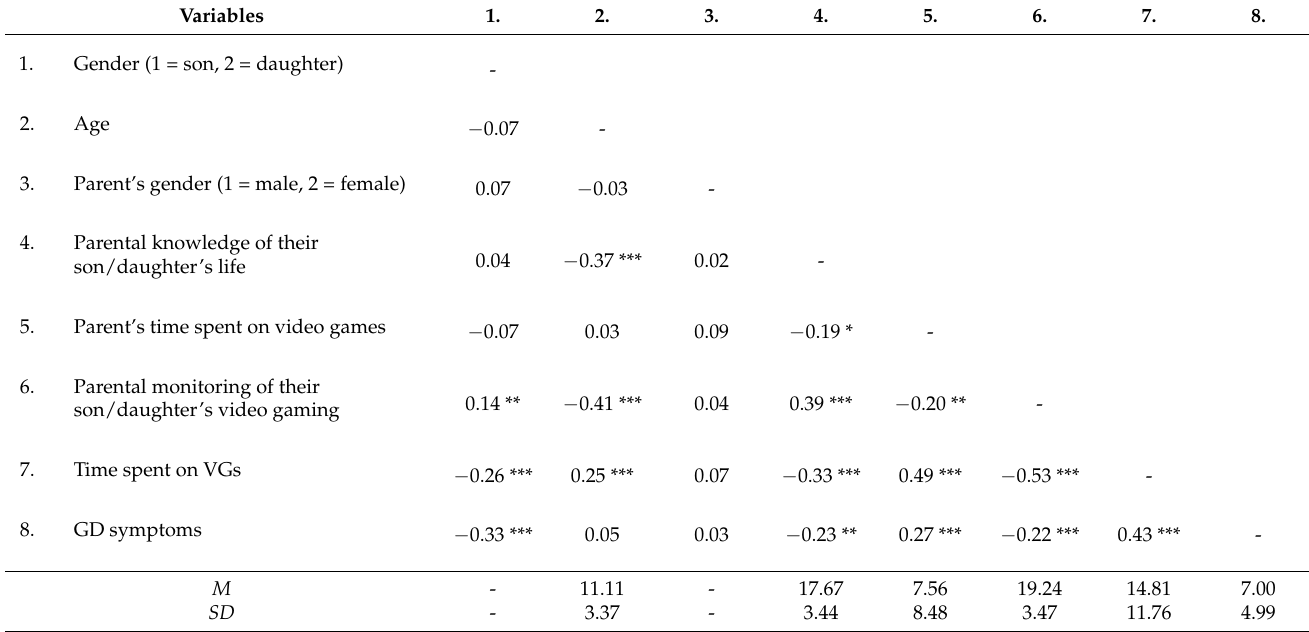
Table 3. Correlations between the offspring’s gender and age, the parents’ gender, parental knowledge of their offspring’s life, parental monitoring of their offspring’s video gaming, the parents’ time spent on VGs, and the offspring’s time spent on VGs and GD symptoms. 1. 2. 3. 4.